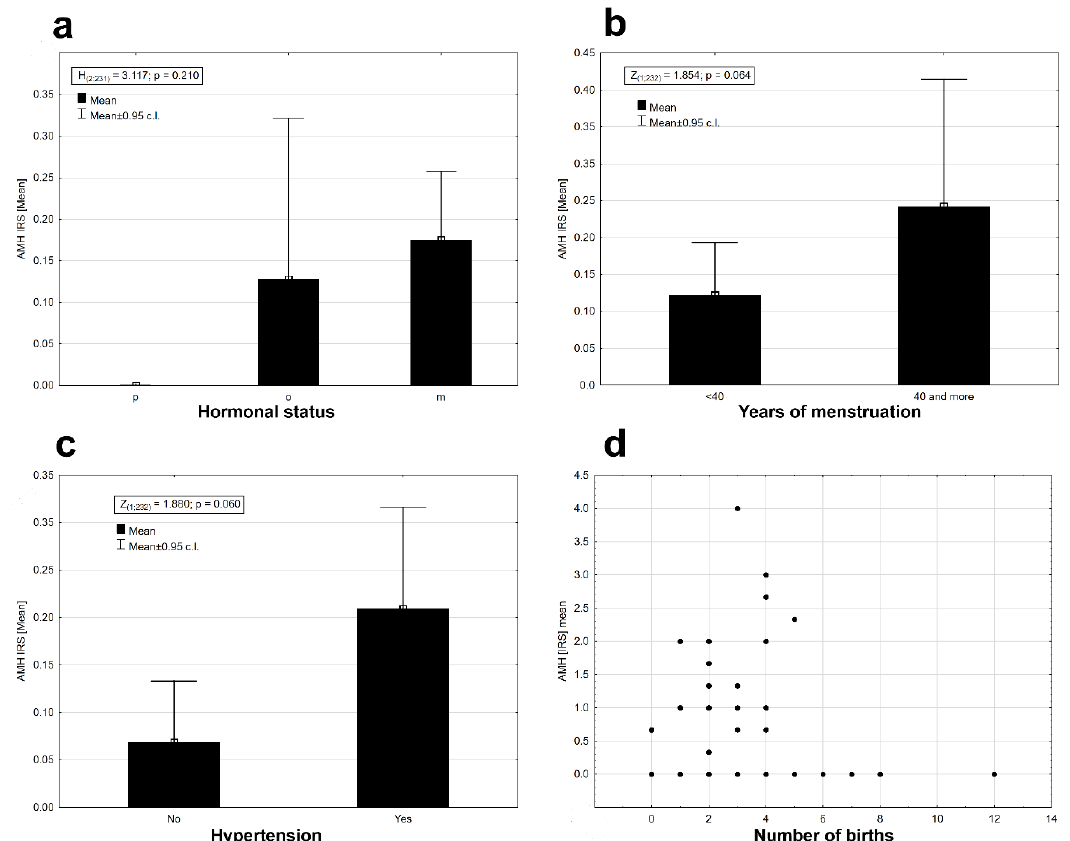
Figure 3. Mean AMH expression: ( a ) in premenopausal (p), perimenopausal (o) and postmenopausal (m) women (Kruskal–Wallis ANOVA: H (2, N = 231) = 3.117, p = 0.210); ( b ) in the group of women that menstruated less than 40 years or more than 40 years (Mann–Whitney U test: Z = 1.854, p = 0.064); ( c ) in the group of patients without and with arterial hypertension (Mann–Whitney U test: Z = 1.880, p = 0.06); ( d ) depending on the number of births (r s = 0.021, n = 232, p =